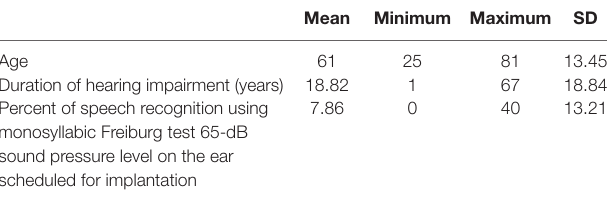
TaBle 1 | general patients’ characteristics. TaBle 2 | Questionnaires used in this study.